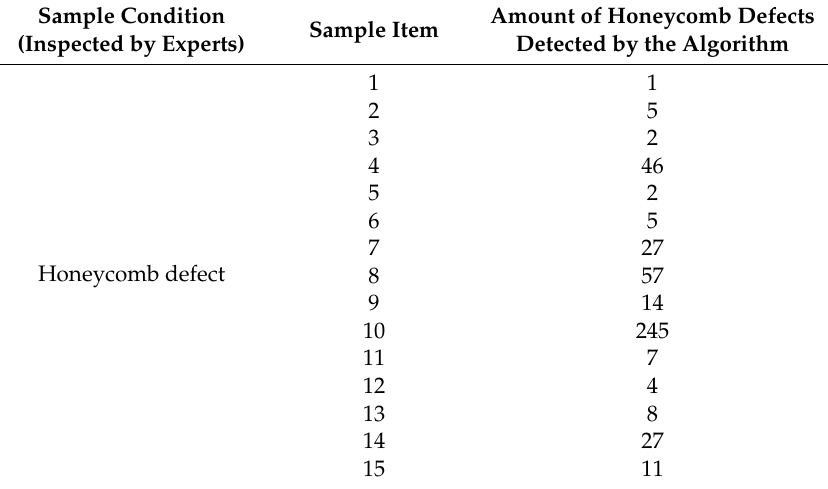
Figure 6. Image processing results for slight defect of honeycomb. ( a ) The slight defect of honeycomb. ( b ) The slight defect of honeycomb’s result show at CLAJE image. ( c ) Zoom-in of the slight honeycomb defect. Table 4. Experiment results for honeycomb defect detection.